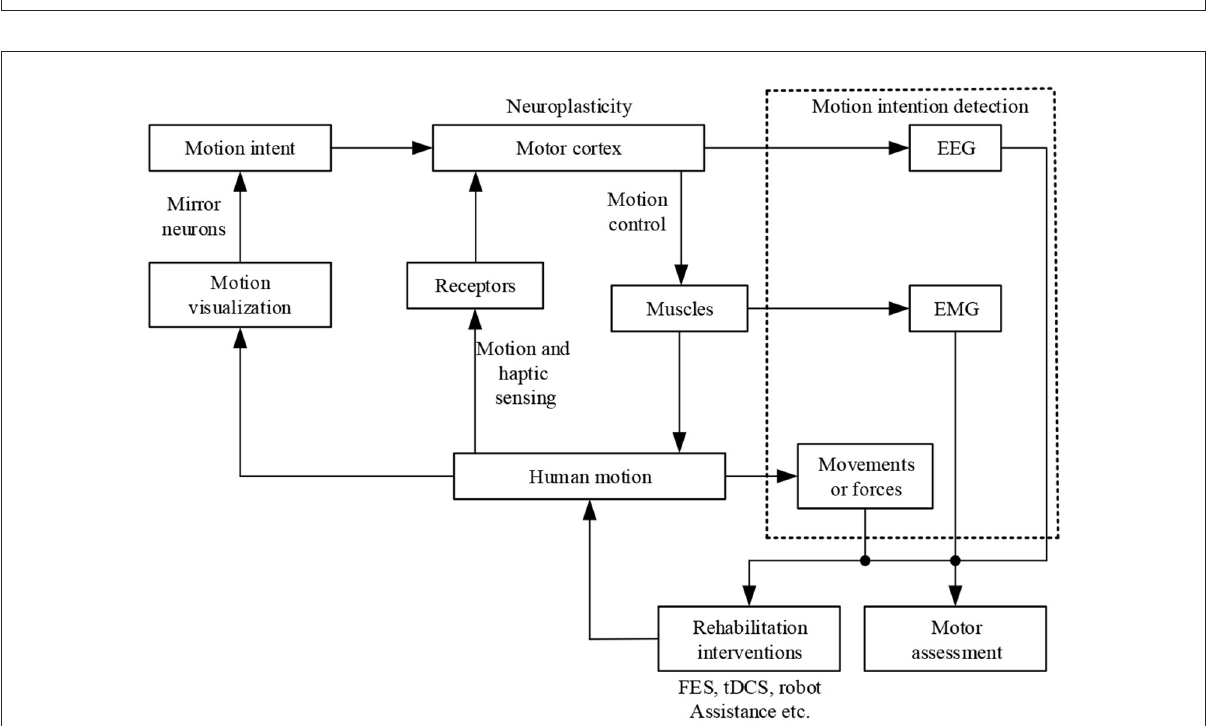
FIGURE9 Human intent-controlled motor reconstruction for stroke victims ( Li et al.,